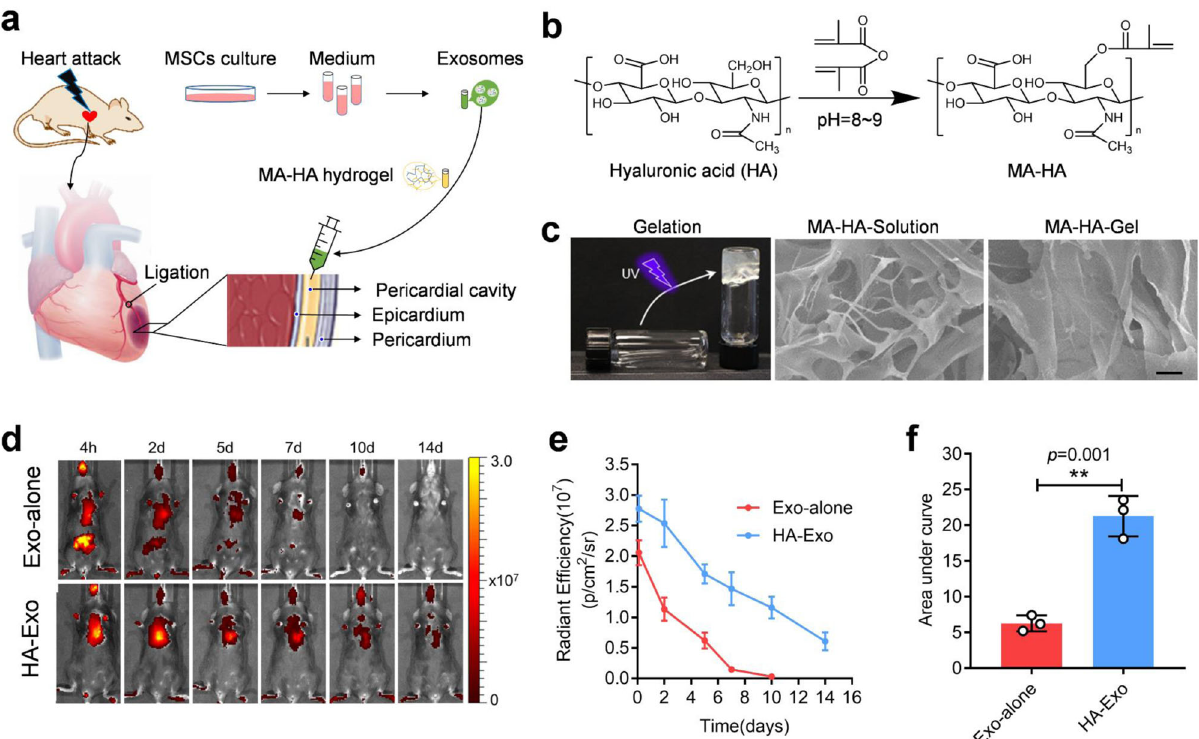
Fig. 3 iPC injection of MSC exosomes in MA – HA hydrogel in a mouse model of acute MI. a Schematic showing intrapericardial delivery of exosomes for MI therapy. b Synthesis of MA – HA hydrogel. c In vitro gelation of MA – HA hydrogel under UV irradiation and SEM images of MA – HA hydrogel before and after gelation. Scale bar, 50 μ m. The gelling process was repeated three times independently with the similar results. d Fluorescent imaging of mice after iPC injection of DiD-labelled exosomes with or without MA – HA hydrogel. e Quantitative data of fl uorescence intensity. Data were shown as mean ± SD, n = 3 animals per group. f The area under curve was determined. Data were shown as mean ± SD, n = 3 animals per group. Comparison of two groups was performed with the unpaired, two-tailed Student ’ s t -test, *** p < 0.001. Source data are provided as a Source Data fi le. MSCs mesenchymal stem cells, MA – HA methacrylated hyaluronic acid, Exo